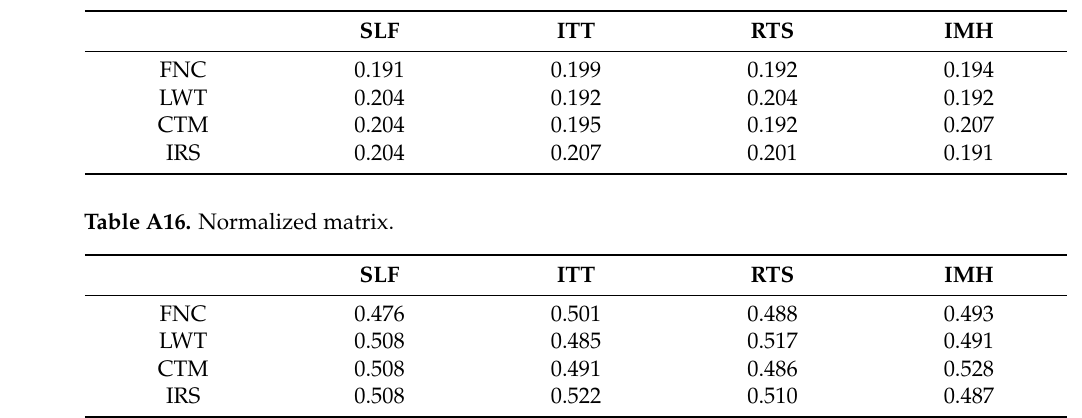
Table A15. Score function values of the competencies.